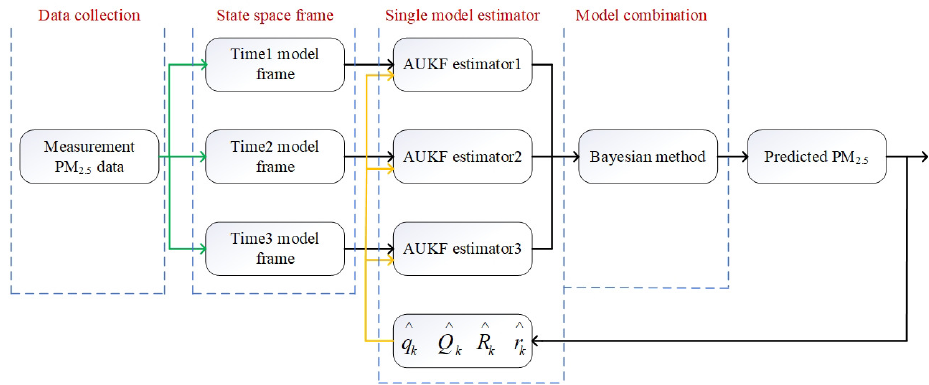
Figure 6. The structure chart of the MMAUKF method for PM 2.5 concentration